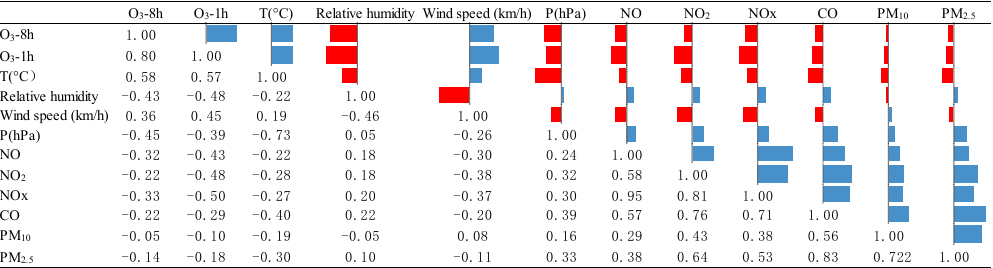
Table 2. Correlation diagrams and correlation coefficients of O 3 with other six pollutants and four meteorological factors ( n = 8760).